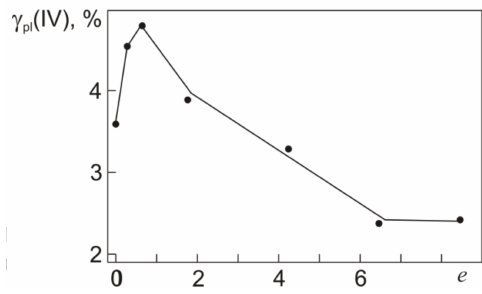
Figure 8. Plastic strain γ pl (IV) corresponding to τ 0.3 (IV) early in stage IV in torsion at 295 K for Ti 49.8 Ni 50.2 after abc pressing with di ff erent true strains e .